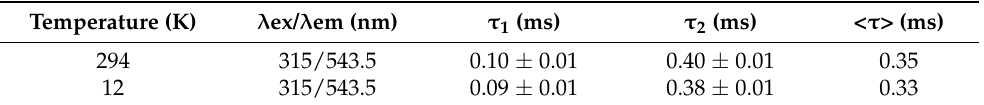
Table 1. 294 K and 12 K emission lifetime values and average lifetime fitted by a second order